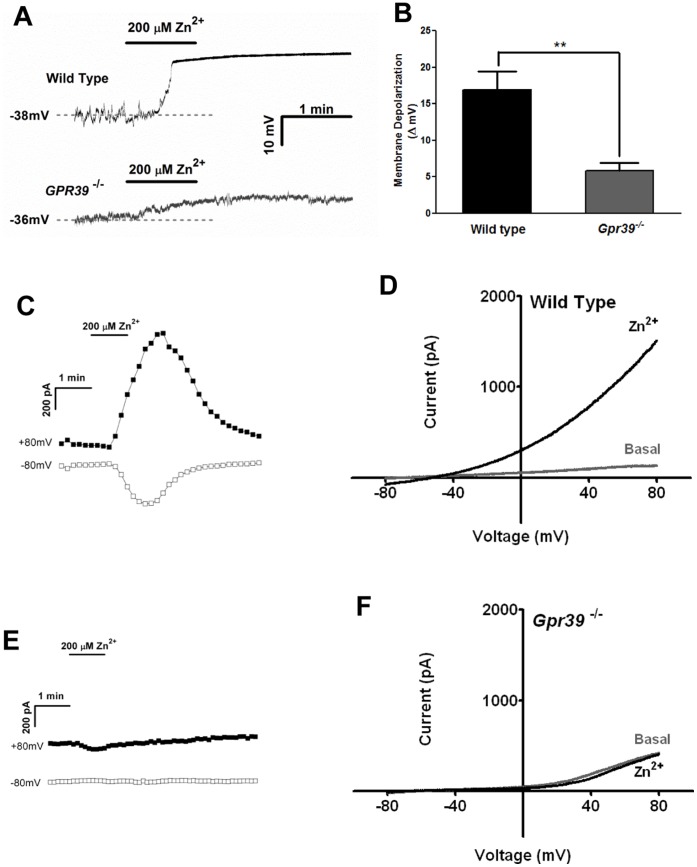
Zn2+ induces a large current in FLCs.(A) Membrane potentials were recorded in current clamp configuration. Zn2+ induced rapid membrane depolarization in FLCs cultured from wild-type mice, but not Gpr39
−/− cells. (B) Bar chart summarizing Zn2+ induced membrane depolarization in FLCs as in panel A. p<0.01. (C and D) Zn2+ induced a large current in wild-type. Current was sampled at +80 and −80 mV. (C) shows a time-series plot for a typical Zn2+-induced current in FLCs (n = 21). (D) shows the corresponding I-V relationship. (E and F) are similar experiments using FLCs isolated from GPR39 knockout mice and show that no Zn2+-induced current was observed in Gpr39
−/− FLCs (n = 11).